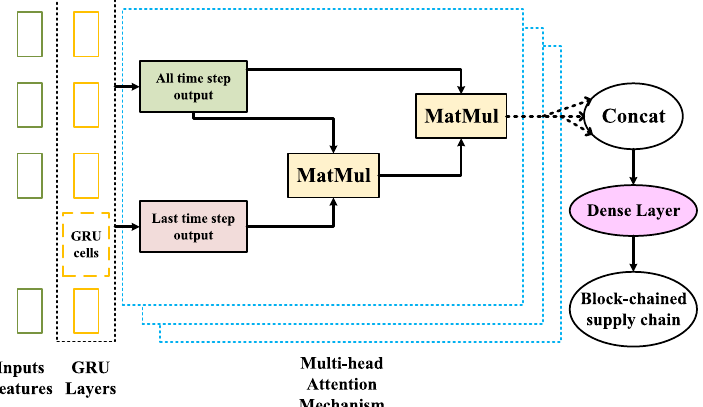
Fig. 8 Structure of Multi-Head Attention GRU